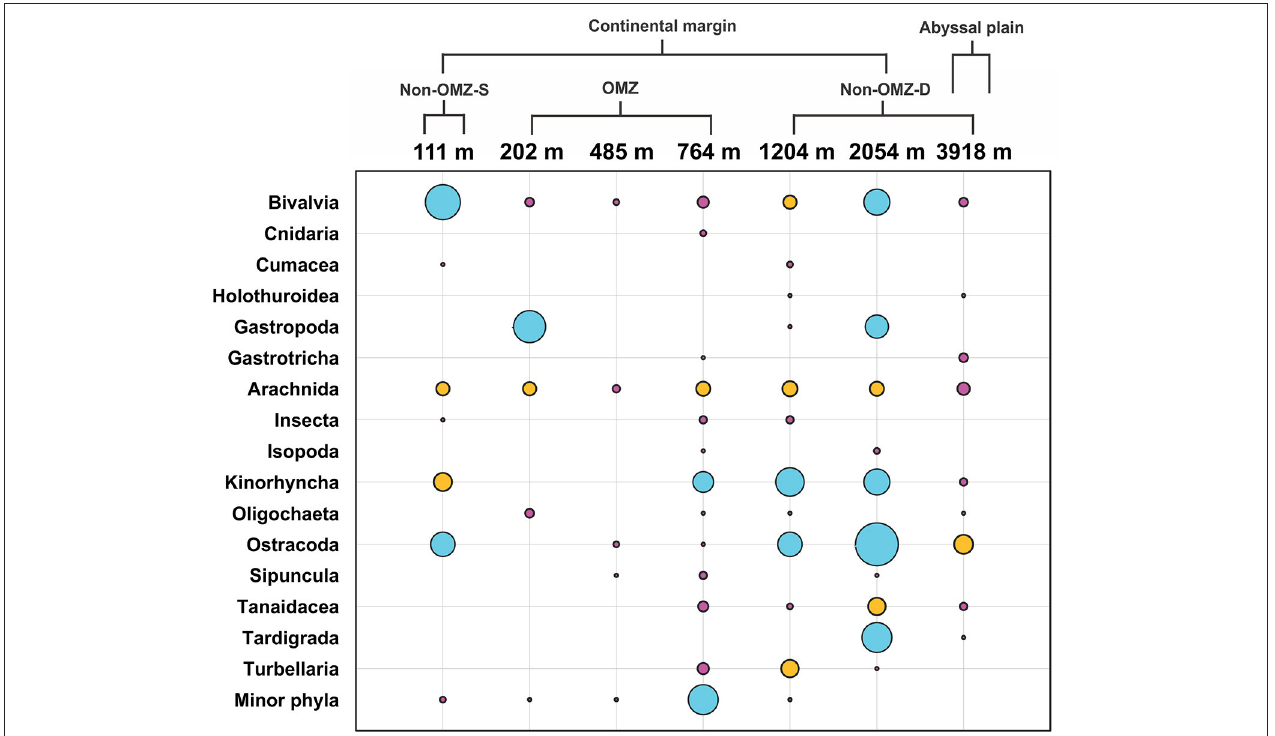
FIGURE 5 | Structure of meiofaunal rare taxa along the depth gradient of WICM and abyssal plain. The bubble size is equivalent to the density of meiofauna in ind. 10 cm − 2 , the blue bubble signifies value ranges between 1 and 4.5, while the yellow ranges between 0.5 and 1, and pink < 0.5.